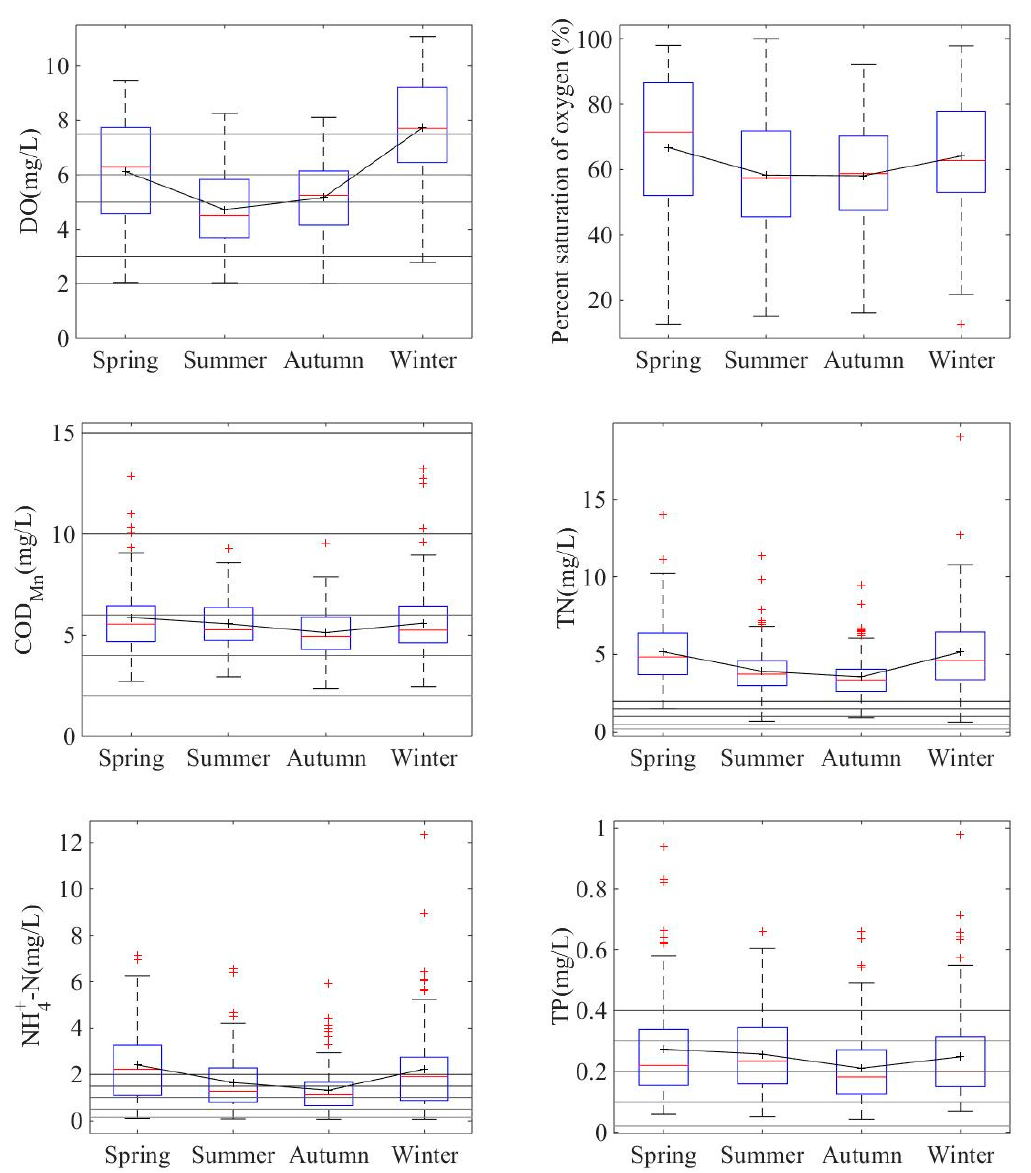
Figure 4. Changes in the mean values and boxplots of the average concentrations of indicators in each season from 2010 to 2014 relative to different levels of the GB3838-2002 standards (the lines of the Class V standard to the Class I standard gradually change from black to 50% gray; the curves represent the mean values, the black ‘+’ symbols represent the mean values of the data, the red lines represent the median values of the data, the edges of the boxes are the 25th and 75th percentiles, the whiskers extend to the most extreme data points that were not considered outliers by the algorithm, and the outliers are plotted individually as red ‘+’ symbols).